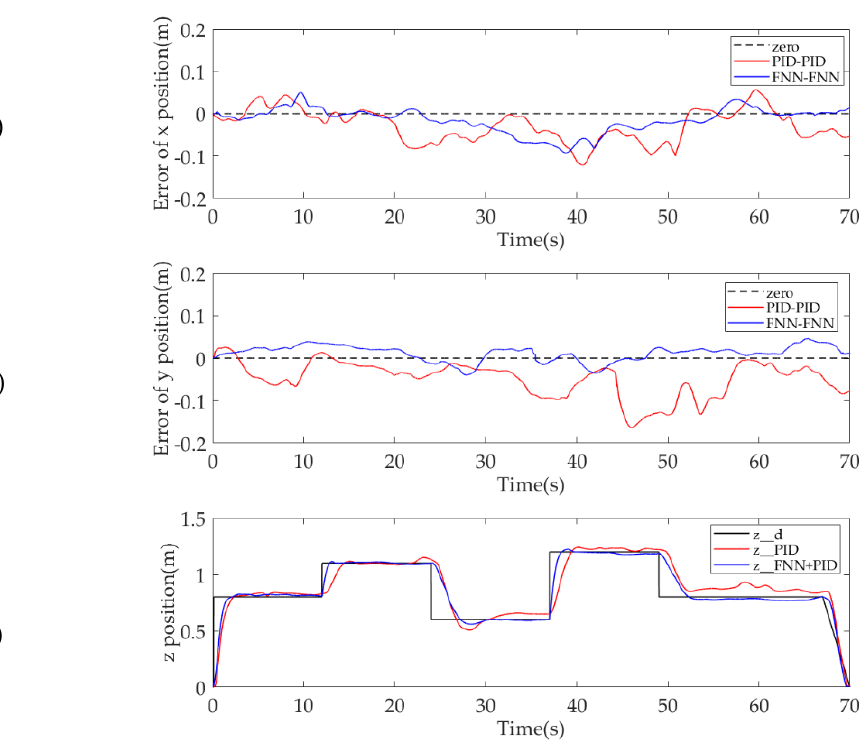
Figure 11. Experiment results of hovering flight with step height command. ( a ) Error of x position, ( b ) Error of y position, ( c ) z position.